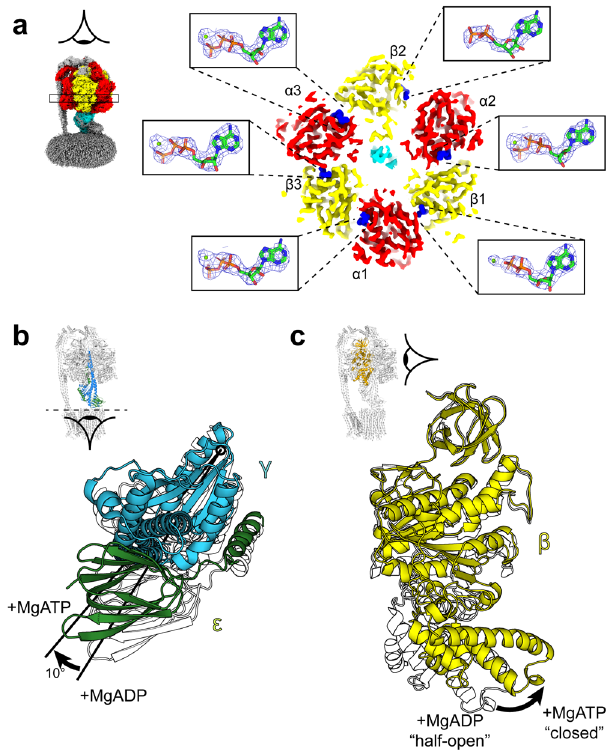
Fig. 2 Nucleotide occupancy and conformational changes in the F 1 motor following incubation with MgATP. a Horizontal section of the State 2 E. coli F 1 F o ATP synthase cryo-EM map and details of the β subunit catalytic site occupancies (with equivalent mitochondrial F 1 nomenclature: 5 β 1 = β DP , β 2 = β β 3 = β E. coli enzyme 16 ). β 1 contains MgADP, E , TP , as named for the β 2 contains ADP, and β 3 contains MgATP. Section of map contoured to 0.028 in ChimeraX 62 and mesh for nucleotides contoured to isolevel 10 in PyMol (Schrödinger). b , c Comparison of the F 1 motor after incubation with MgATP (this study; γ in blue, ε in green and β in yellow) or MgADP (PDB:6oqv 19 ; subunits shown as outline). b The central stalk (subunits γ and ε ) is rotated ~10° clockwise when viewed from the membrane (structures are aligned to the F 1 β barrel crown). c β 1 closes inwards from a half-open to closed conformation. Fig. 3 E. coli F 1 F o ATP synthase ε subunit in three conformational sub- states. Cryo-EM maps (transparent surface) and molecular models (cartoon representation) of the E. coli F 1 F o ATP synthase rotor in three conformation sub-states. Subunit γ in light blue and ε in green, with the foot helix of subunit γ labeled in dark blue. a The ε CTD up sub-state observed after addition of 10 mM MgADP (PDB:6oqv; EMDB:20171 19 ). b The ε CTD half-up sub-state observed after addition of 10 mM MgATP (State 2 half-up in this study). c The ε CTD down sub-state observed after addition of 10 mM MgATP (State 2 down in this study). See Supplementary Fig. 5 for close up views of the cryo-EM maps for the ε CTD and γ